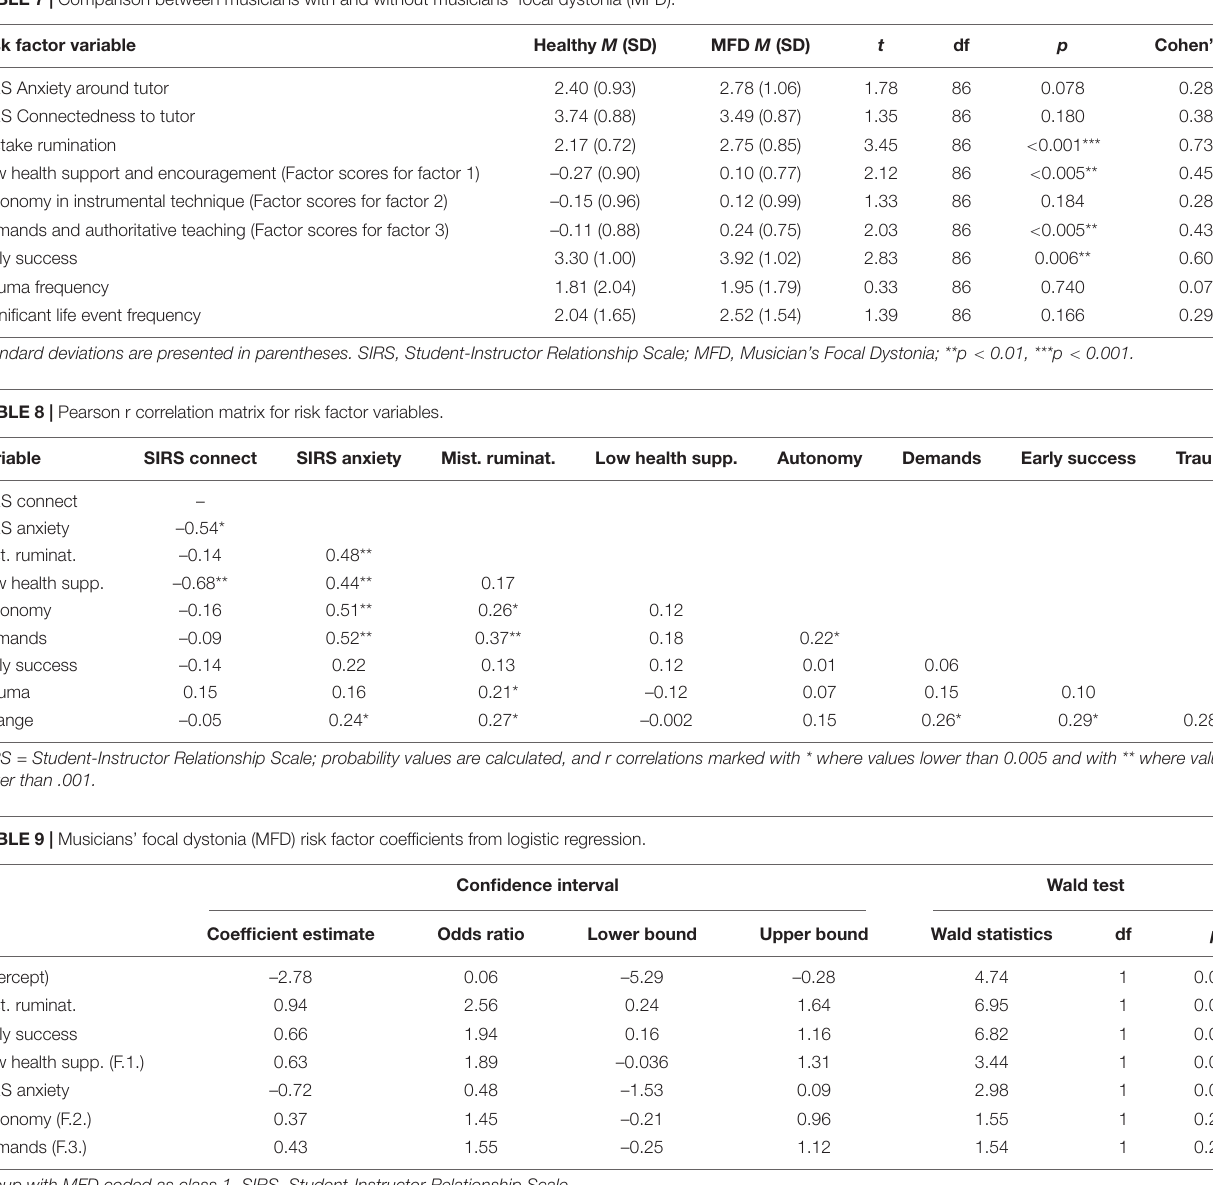
TABLE 7 | Comparison between musicians with and without musicians’ focal dystonia (MFD).